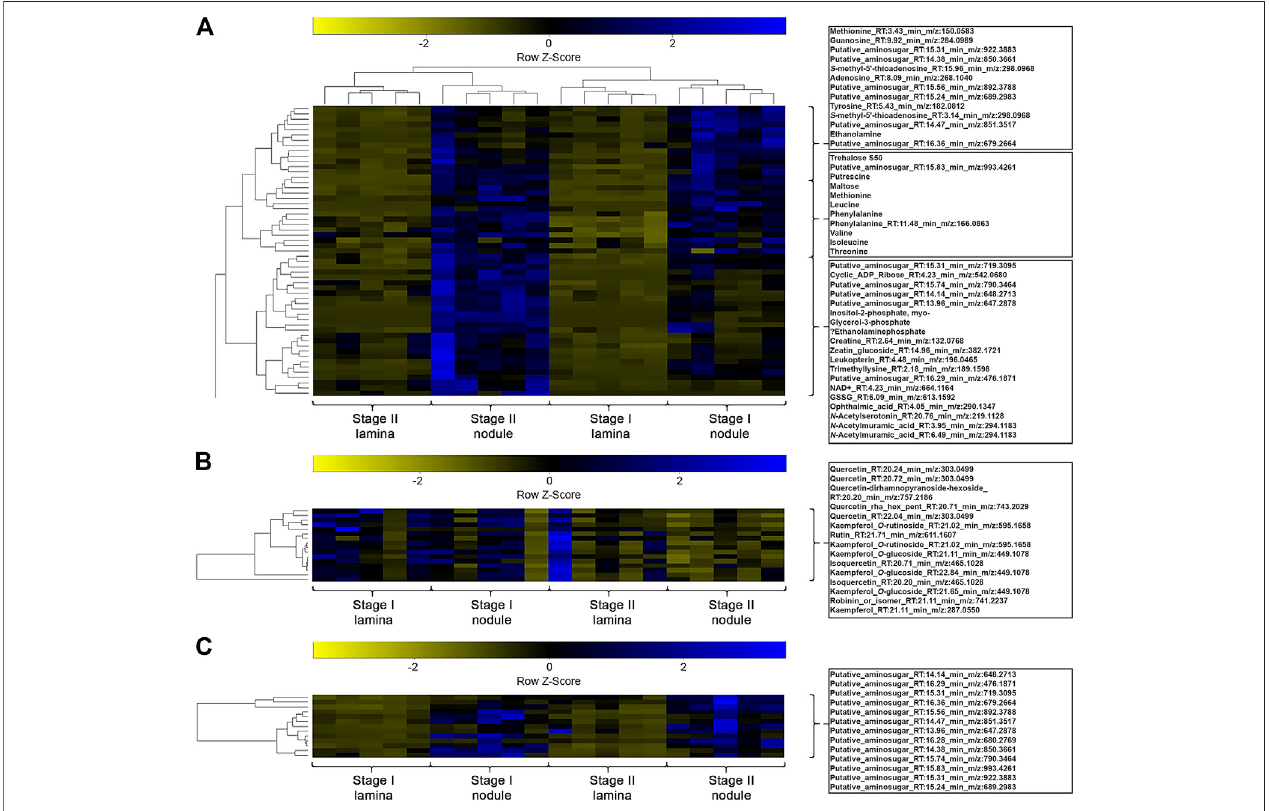
FIGURE 5 | (A) Heatmap of a hierarchical bicluster analysis of statistically signi fi cant changed nodule speci fi c metabolites of Psychotria punctata tissue extracts (selected metabolite names do not corresponds with rows). The columns correspond to the fi ve biological replicates of each condition. (B) Heatmap of a hierarchical cluster analysis of m/z features annotated as fl avonoids of P. punctata tissue extracts. The columns correspond to the fi ve biological replicates of each condition. (C) Heatmap of a hierarchical cluster analysis of m/z features annotated as anhydromuropeptdides of P. punctata tissue extracts. The columns correspond to the fi ve biological replicates of each